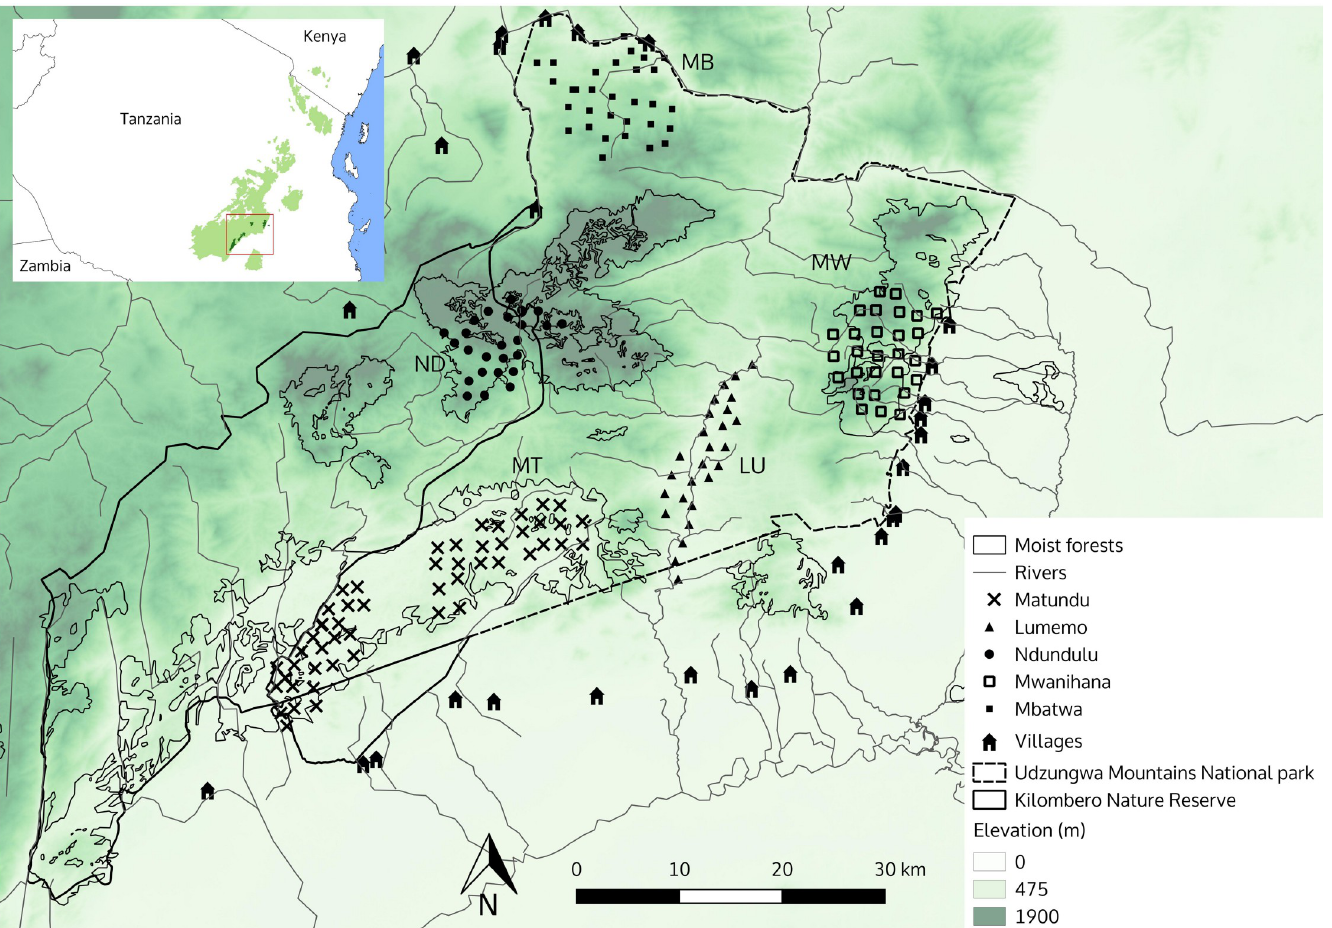
Fig 1. Study area. Map of the Udzungwa Mountains of Tanzania, showing the National Park, the Kilombero Nature Reserve and the location of six camera trap arrays placed in five different areas (MT = Matundu, MB = Mbatwa, LU = Lumemo, ND = Ndundulu, MW = Mwanihana) characterised by different habitat types (Table 1). The background layer is a Digital Elevation Model, with darker colour indicating higher elevation.